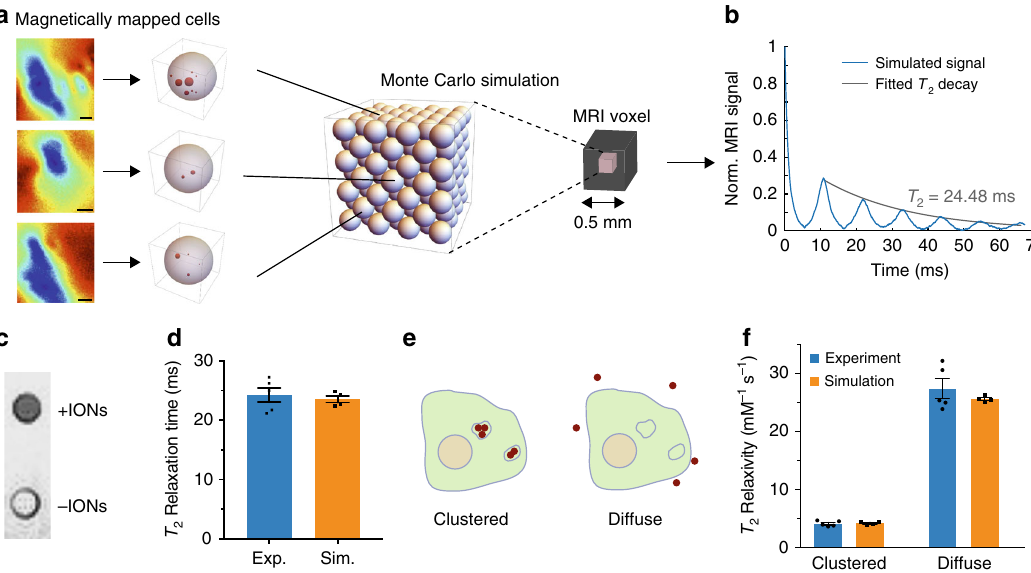
Fig. 2 Predicted and experimental MRI behavior in cells. a Schematic of Monte Carlo modeling of spin relaxation using NV-mapped magnetic fi elds. A library of 11 cells mapped with vector magnetometry (three representative cells shown) in a 1:1 mix with unlabeled cells, was used to randomly fi ll a 108-cell FCC lattice with periodic boundary conditions and run a Monte Carlo simulation of spin-echo MRI to predict T 2 relaxation behavior. b Representative simulated MRI signal. c T 2 -weighted MRI image of cell pellets containing a 1:1 mixture of supplemented and unsupplemented cells (+ IONs and – IONs, respectively) or 100% unlabeled cells (bottom). d Simulated and experimentally measured T 2 relaxation times for the 1:1 mixture. e Illustration of the same quantity of magnetic particles endocytosed or distributed in the extracellular space. f Simulated and experimentally measured relaxivity for endocytosed and extracellular distributions of IONs. Measurements and simulations have N = 5 replicates. All error bars represent ±